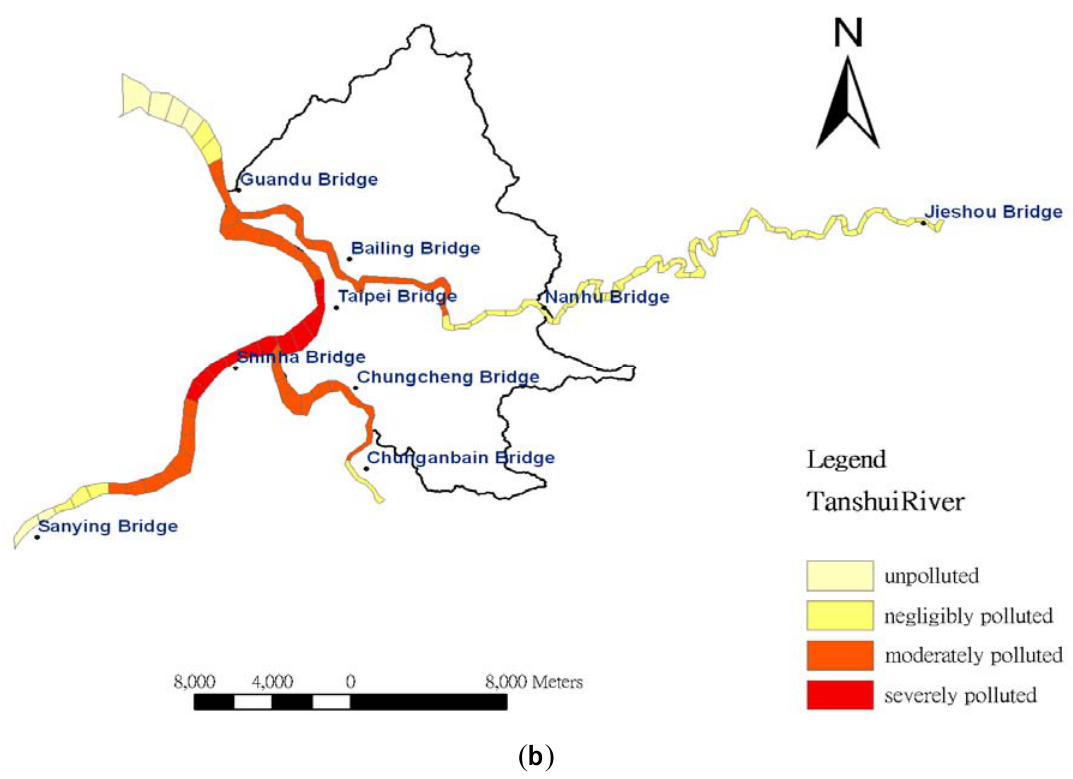
Figure 8. Temporal variation in RPI of the Tanshui River at approximately 23 river